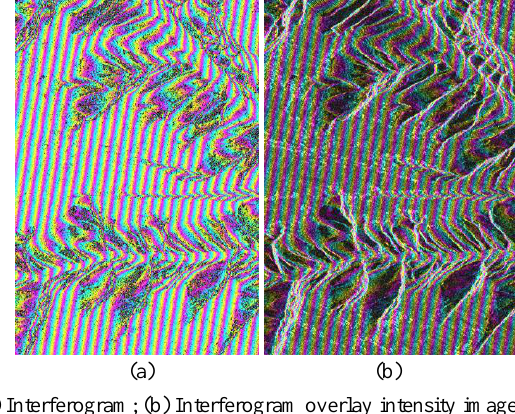
Figure 4. Interferogram results